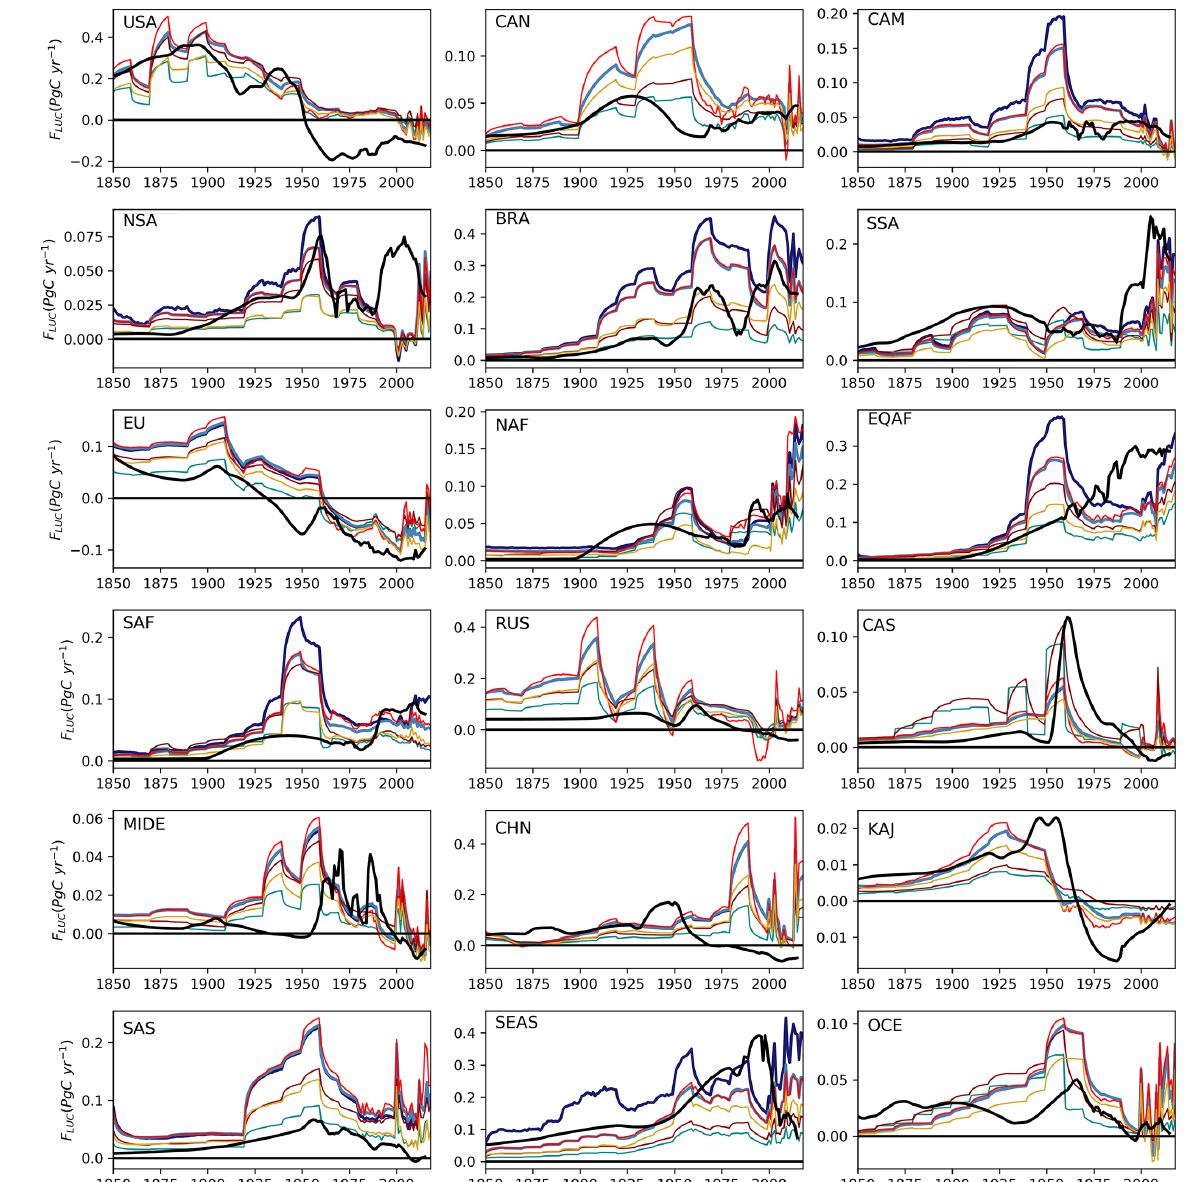
Figure 3. Regional F LUC between 1850 and 2015 from the two BK model estimates in GCB2019 (HN2017 in black and S BL for BLUE in dark blue), the BLUE simulations with net LUC transitions and standard parameterisation (light blue, S BL-Net ) and using HN2017 parame- terisations (cyan, S HNFull ). The factorial simulations with only one set of parameters changed are shown in thin lines ( S HNCdens in dark red, S HNt in red, S HNAlloc in